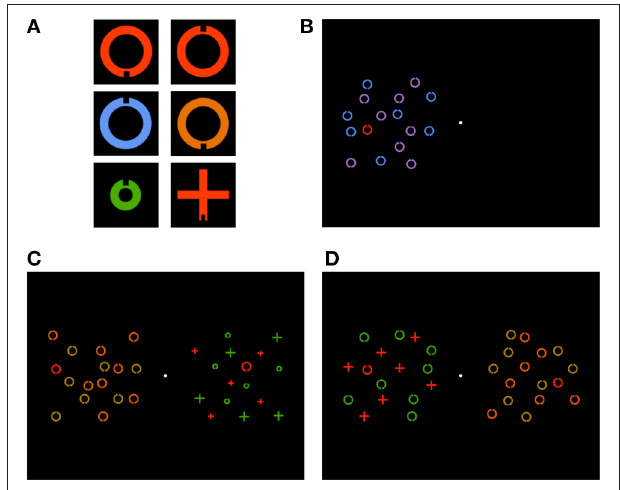
FIGURE 1 | Example (A) targets with a notch located at the bottom and top of ring (top row), feature-low and feature-high distractors (middle row) and conjunction-low and conjunction-high distractors (bottom row), (B) control trial in the feature-low condition, with display objects in the left hemifield, (C) test trial in the high-low condition with feature and conjunction search in the left and right hemifields, respectively, and (D) test trial in the high-high condition with feature and conjunction search in the right and left hemifields,